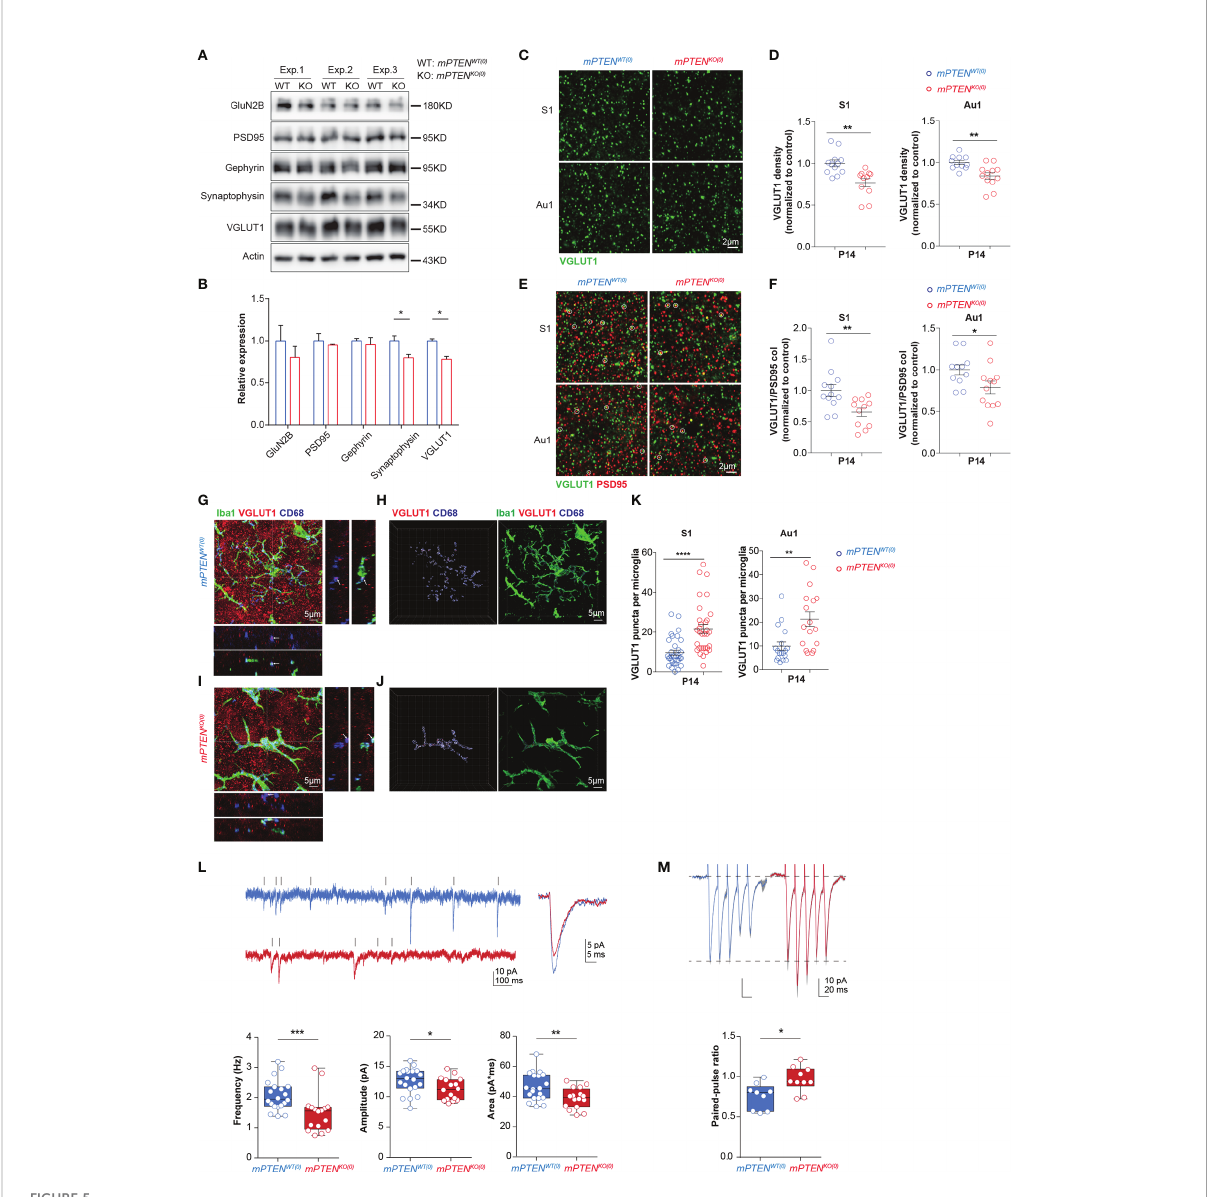
FIGURE 5 Defects of mPTEN KO(0) mice at P14. (A, B) Western blotting of presynaptic proteins (VGLUT1, synaptophysin), postsynaptic proteins (PSD95, GluN2B), and inhibitory synaptic protein Gephyrin in 2-3-month cortex (A) and actin-normalized expression levels (B) . Bar graphs show mean ±s.e.m. of the three (Exp. #1, #2, #3) experiments. * P < 0.05 by unpaired t test. (C, D) Representative images of VGLUT1 staining of the S1 and Au1 cortex (C) , and scatter plots showing densities of VGLUT1 puncta in S1 and Au1 cortex (D) . (E, F) Representative images of VGLUT1 and PSD95 staining of the S1 and Au1 cortex, with VGLUT1/PSD95 co-localized puncta highlighted with circles (E) , and scatter plots showing densities of VGLUT1/PSD95 puncta in the S1 and Au1 cortex (F) . Data were collected from 3 mice per genotype (for each mouse, 5 fi elds in S1 and 5 fi elds in Au1 cortex). Each symbol is one fi eld, and lines denote mean ± s.e.m. * P <0.05, ** P <0.01, by unpaired t tests. (G-J) Maximum intensity projection image of an mPTEN WT(0) (G) or mPTEN KO(0) (I) Iba-1 + (green) microglia that contains VGLUT1 + (red) puncta within CD68 + vesicles (blue). XZ and YZ views show localization of VGLUT1 puncta within CD68 vesicles at crossing points highlighted in projection images. 3-D views of the images in (G, I) are shown in (H, J) , respectively, with VGLUT1, CD68 and Iba-1 staining rendered as iso-surfaces in Imaris. (K) Numbers of VGLUT1 puncta per microglia in S1 (left) and Au1 (right) cortex. Each symbol in scatter plots represents one 3-D reconstructed microglia, and lines denote mean ± s.e.m. Data were collected from 3 P14 mice of each genotype, each contributing 5-6 randomly chosen microglia in the S1 and Au1 cortex, respectively. ** P < 0.01, **** P < 0.0001, by unpaired t tests. (L) Example recordings of mEPSCs of L5 pyramidal neurons from P14-16 mPTEN WT(0) and mPTEN KO(0) brain slices, and the average mEPSC amplitude, frequency and area (mPTEN WT(0) : n=20, 3 mice; mPTEN KO(0) : n=16, 3 mice). Mann-Whitney tests for amplitude and area, unpaired t test for frequency. (M) Examples of evoked EPSCs and quanti fi cation of the paired-pulse ratio of the evoked EPSCs (mPTEN WT(0) : n=9, 3 mice; mPTEN KO(0) : n=10, 3 mice); unpaired t test. * P < 0.05, ** P < 0.01, *** P <